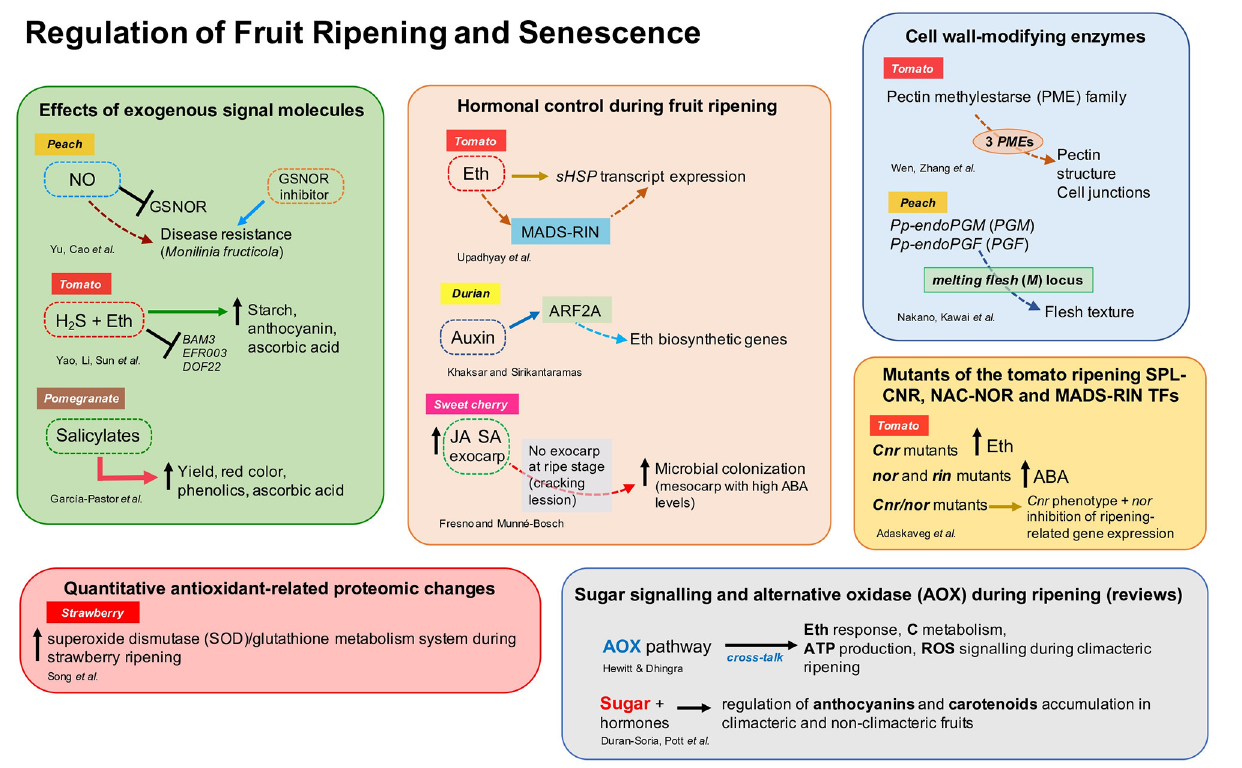
FIGURE 1 | Overview of the different aspects addressed by authors in the Research Topic “Regulation of Fruit Ripening and Senescence.” ABA, abscisic acid; ARF, auxin response factor; Eth, ethylene; GSNOR, S-nitrosoglutathione reductase; H 2 S, hydrogen sulfide; JA, jasmonic acid; NO, nitric oxide; SA, salicylic acid; sHSP, small heat-shock proteins; for other abbreviations, see the respective